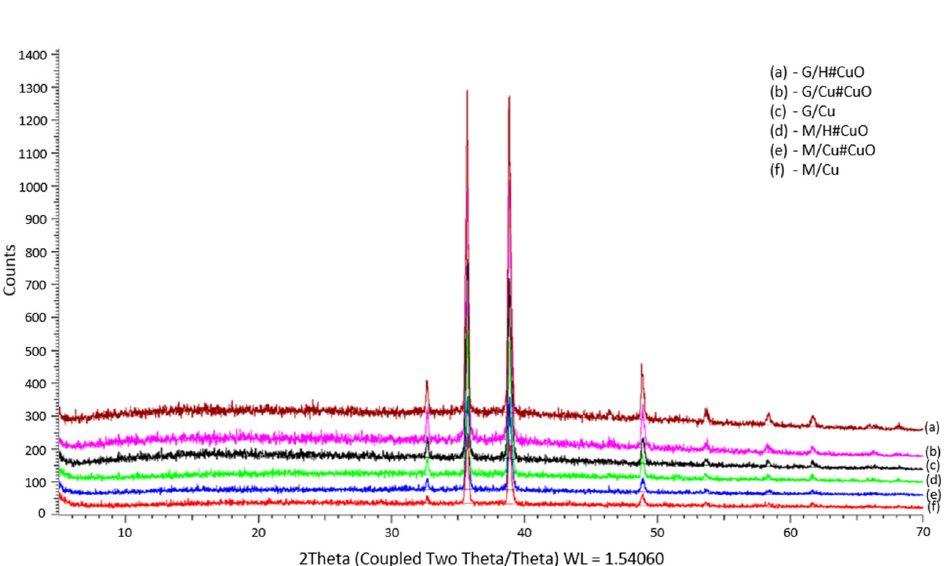
Figure 5. XRD patterns of residues in air.